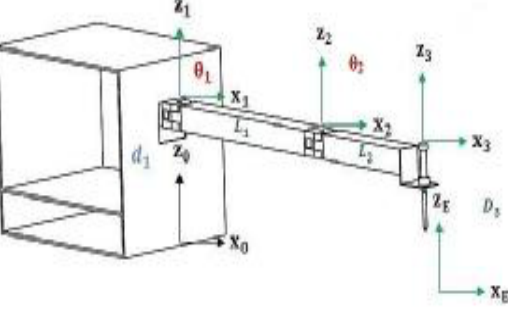
Fig. 2. Frames of Manipulator.